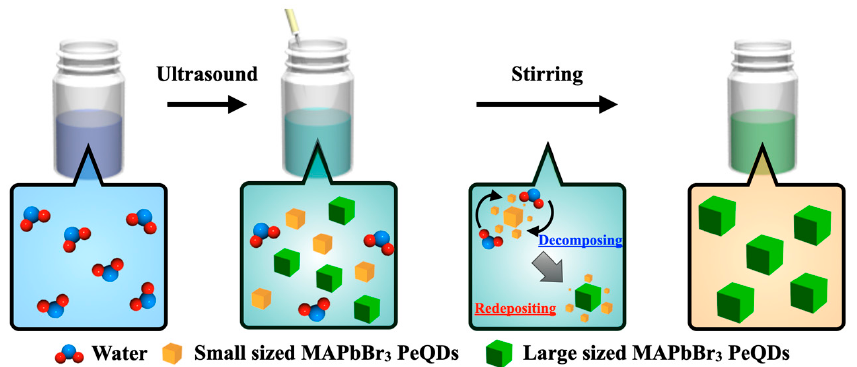
Figure 3. Schematic diagram of the phenomenon of Ostwald ripening produced by the water-assisted LARP method.